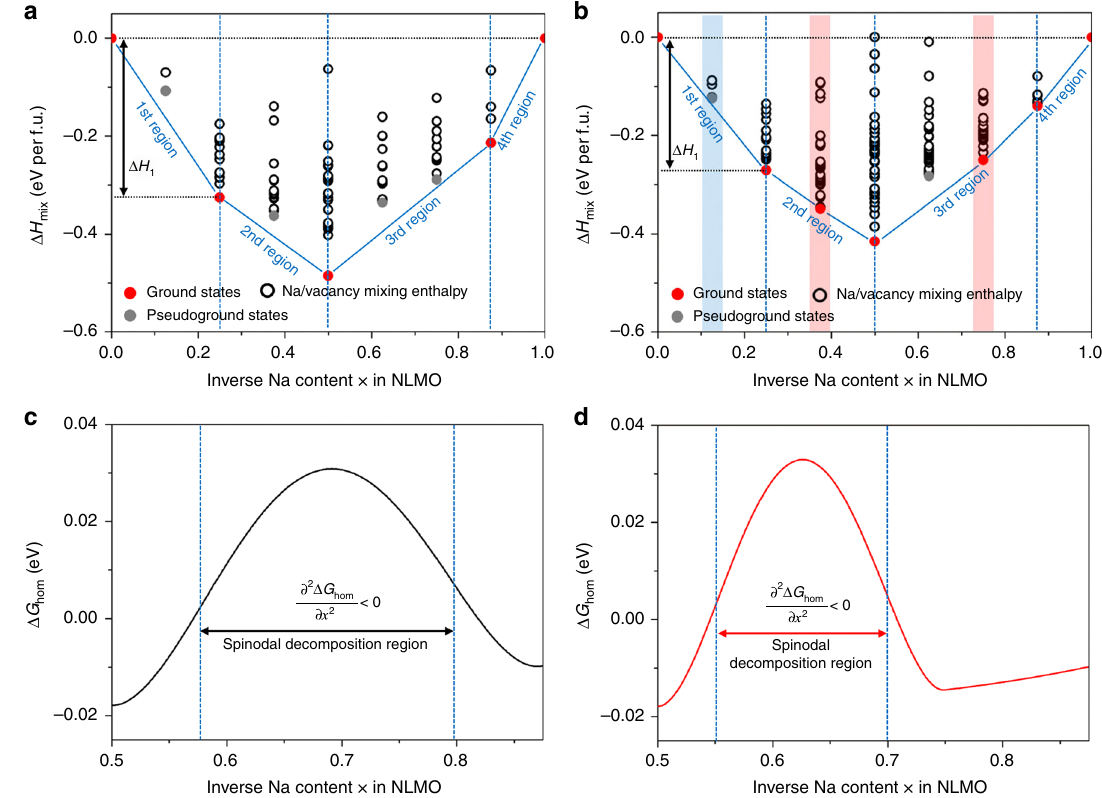
Fig. 2 The phase stability of Na[Li 0.25 Mn 0.75 ]O 2 and Zn-doped Na[Li 0.25 Mn 0.75 ]O 2 with different Na contents. The mixing enthalpy ( Δ H mix ) values were calculated considering all possible Na and their vacancy con fi gurations and the results are shown for Na[Li 0.25 Mn 0.75 ]O 2 ( a ) and Zn-doped Na [Li 0.25 Mn 0.75 ]O 2 ( b ). Here, the two atomic models contain 8 Na atoms in each unit cell structure. Based on statistical thermodynamics, many unit cell structures can be generated based on the combinations of Na and its vacancy sites in the unit cell structure. Among them, one should have the lowest mixing enthalpy value as marked with the red or grey circles in a and b , while the other structures must have higher enthalpy values (marked with white circles). Above the tie lines (blue solid lines), grey fi lled circles are notated as pseudo ground states that are not preferential to exist in certain compositions. In the cases where the ground state as indicated by the red circles lie on the tie lines, these are true ground states as their structures are thermodynamically favourable at the speci fi ed compositions. Δ H 1 indicates the difference between the lowest energy values at x = 0.25 and x = 0.0. Homogeneous bulk free energies are shown for Na[Li 0.25 Mn 0.75 ]O 2 ( c ) and Zn-doped Na[Li 0.25 Mn 0.75 ]O 2 ( d ) at 300 K. In both panels, the range between the dotted lines indicate the spinodal decomposition regions satisfying the condition of ∂ Δ G hom ∂ x 2 <